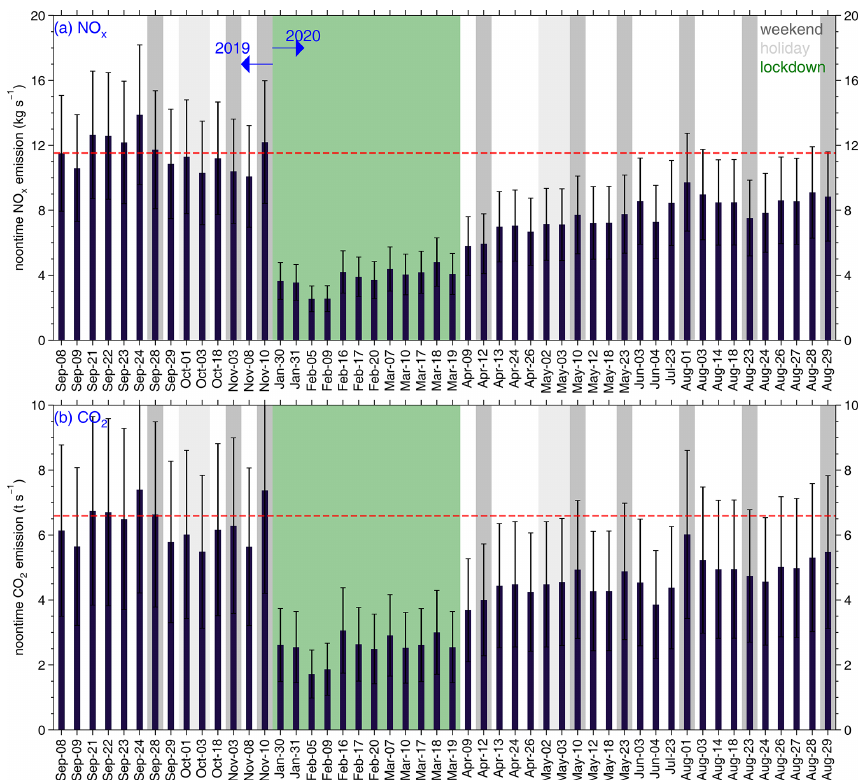
Figure 6. The 50d (a) NO x and (b) CO 2 emissions in Wuhan estimated from TROPOMI between 1 September 2019 and 31 August 2020. The error bars denote the uncertainty in emission estimations, and the weekends, holidays and lockdown period are shaded with dark-grey, light-grey and green colors, respectively. The mean pre-lockdown emission levels are given as dashed red lines.